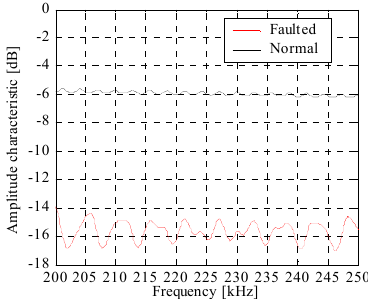
Figure 9. Amplitude characteristics of the faulted power line. The middle phase to ground coupling. The broken middle phase 25 km away from the sending end, with the middle phase conductor short-circuited at the left side and open-circuited at the right side at the fault location.